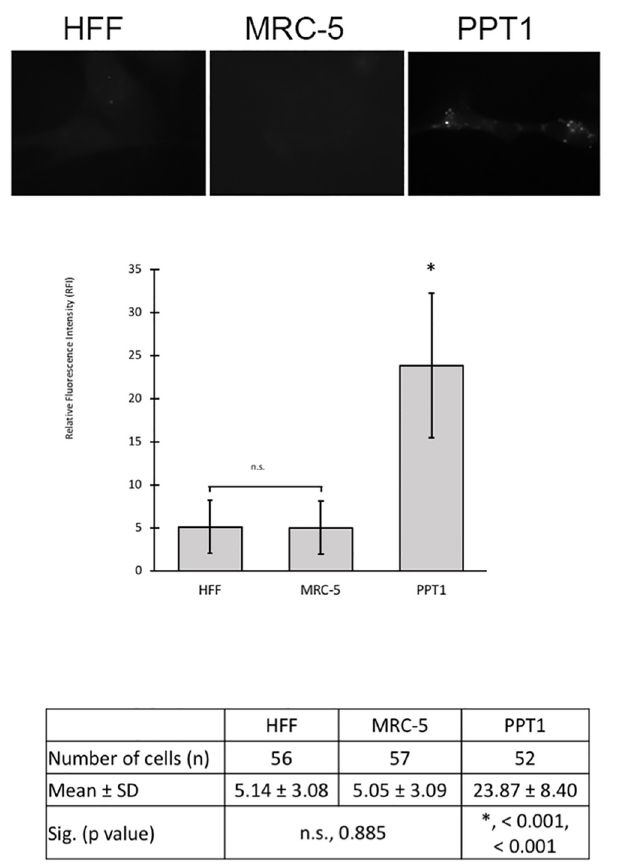
Fig 1. Analysis of autofluorescence in normal and PPT1-deficient fibroblasts.